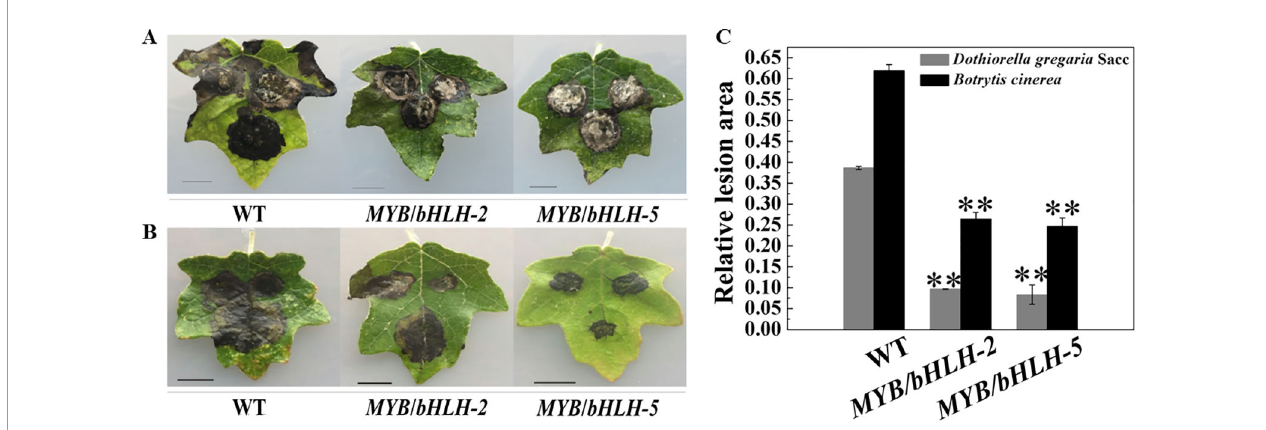
FIGURE 4 | Resistance of transgenic poplar to pathogen infection. Disease symptoms of three leaves of wild-type (WT) and MYB90 / bHLH1 -OE plants after B. cinerea infection for 4 days (A) or D. gregaria infection for 7 days (B) . (C) Ratios of the lesion areas of infected leaves from WT and MYB90 / bHLH1 -OE plants (OE-2 and OE-5 lines). Values represent the means of three replications. Error bars indicate ± SE. Asterisks indicate signi fi cant differences: ** P ≤